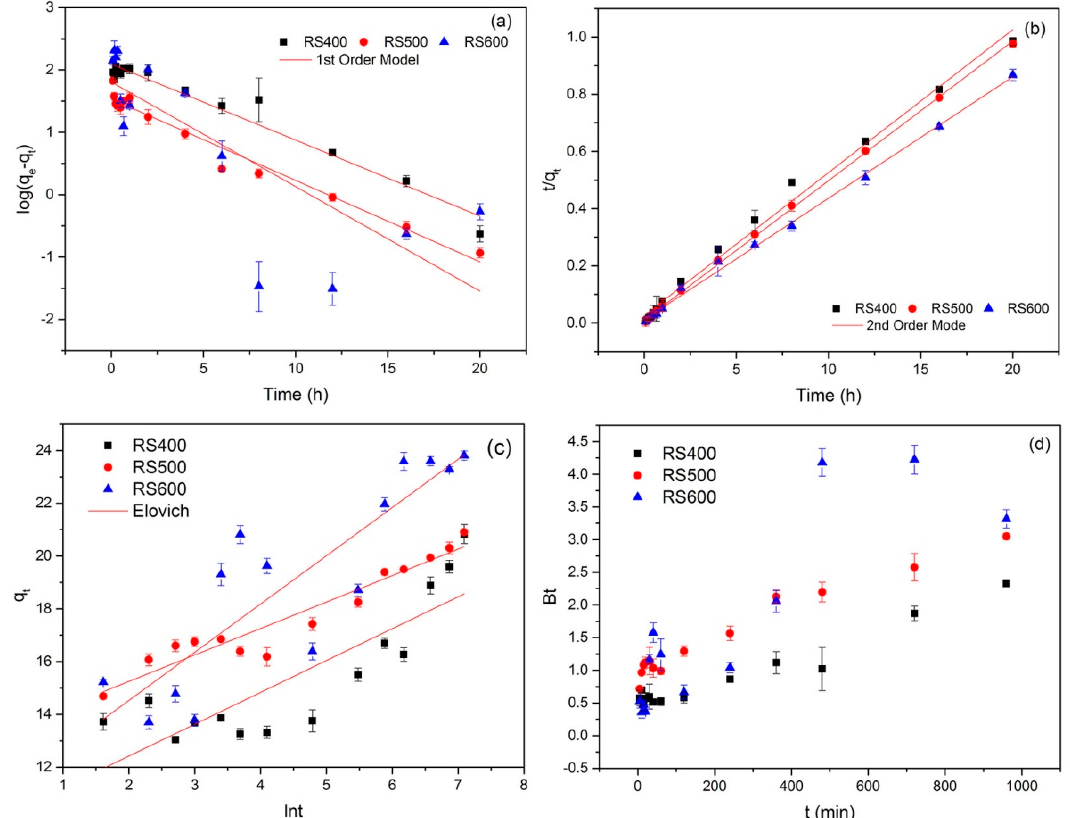
Figure 2. Kinetic plot of the adsorption of BCs on E2. ( a ) pseudo-first-order; ( b ) pseudo-second-order; ( c ) Elovich; ( d ) Boyd (initial concentration = 6 mg L − 1 ; biochar dose = 0.01 g; temperature = 301 K).